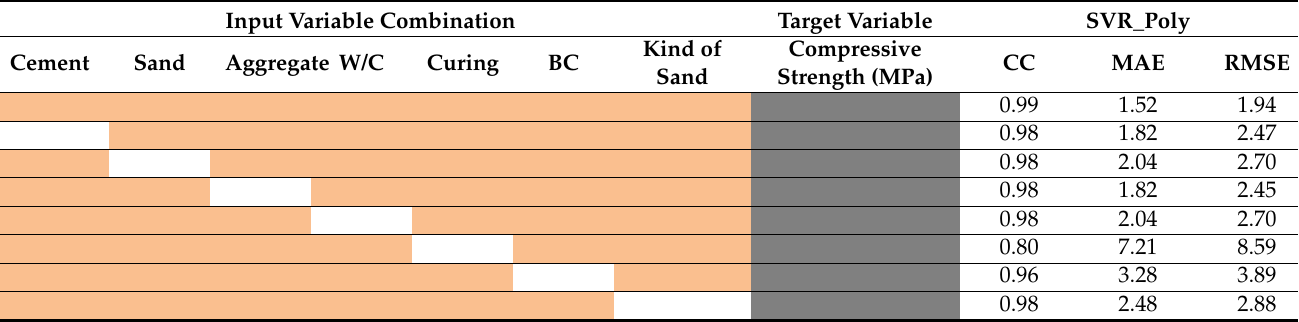
Table 8. Sensitivity results using SVR_Poly based